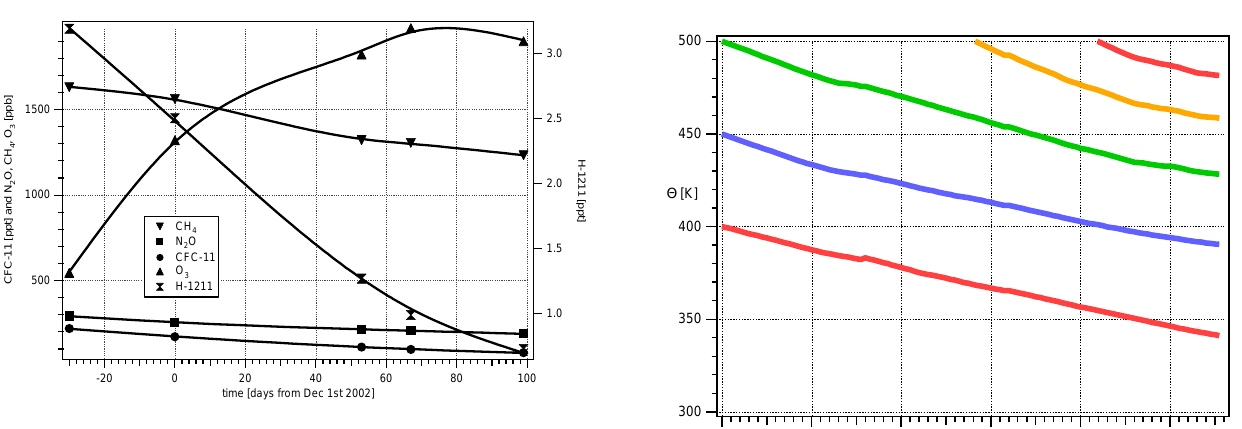
Fig. 4. Averages of tracers at the 400K isentrope in the vortex ver- sus the time ( χ vortex (t) ). The data were fitted with a smoothing spline. Points refer to measurements made during Geophysica cam- paigns and the MKIV flight. Fig. 5. Mean diabatic descent (solid lines) within the vortex derived Fig. 5. Mean diabatic descent (solid lines) within the vortex derived from an ensemble of CLaMS trajectories from an ensemble of CLaMS trajectories starting on 1 December starting on 1 December 2002